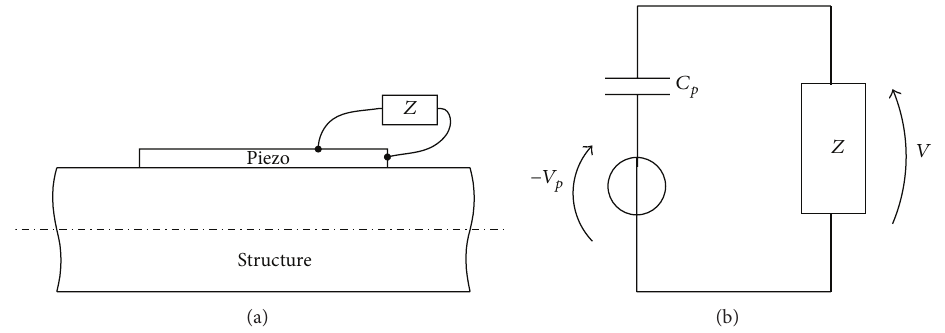
Figure 3: Scheme of a structure controlled by a shunted piezo-actuator (a) and its electrical equivalent (b).